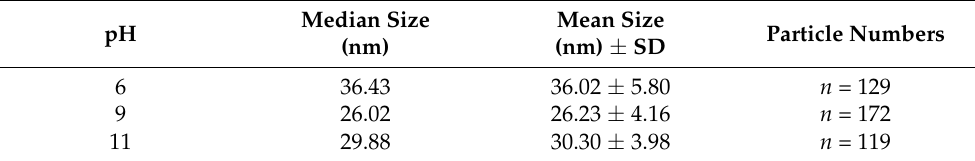
Table 1. TEM-derived size distributions of gallic acid-coated gold nanoparticles with various levels of pH synthesis.